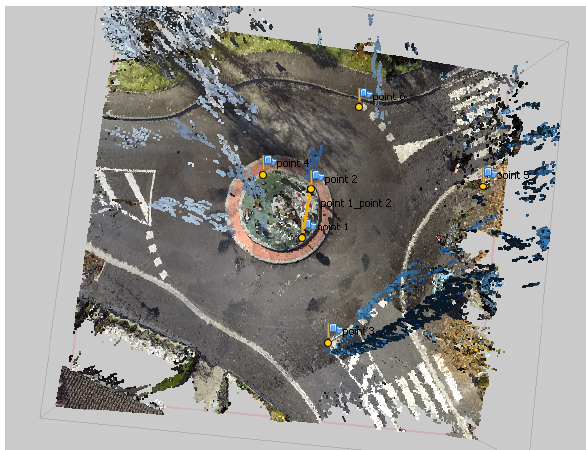
The results are shown on Figure 7.